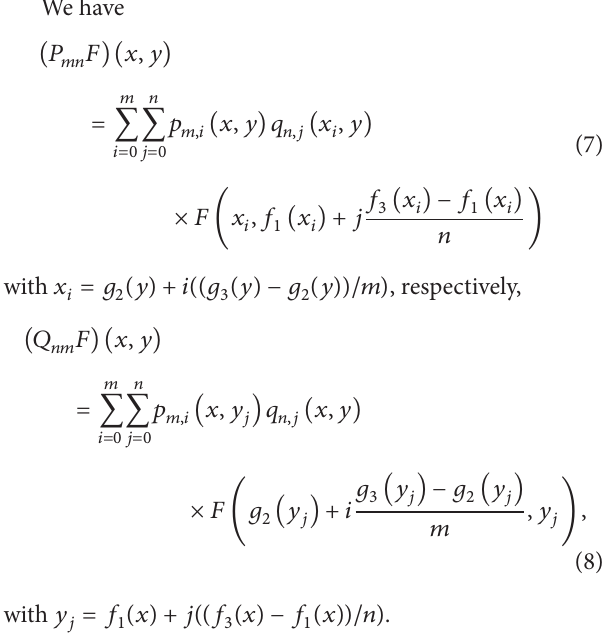
Figure 1: Triangle